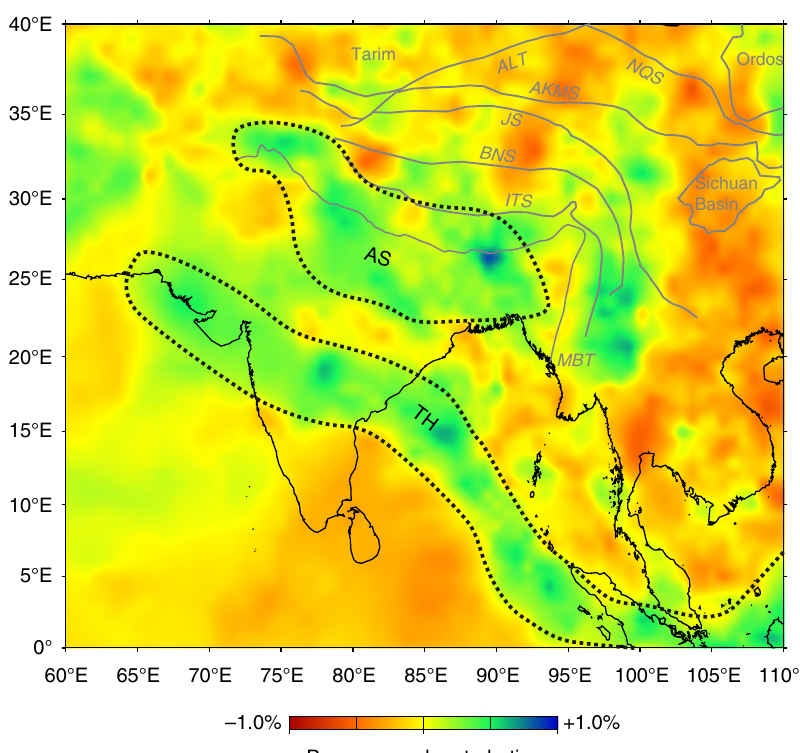
Fig. 7 Tomographic section at 1016 km depth suggesting two previous detachment events. Two high-speed anomalies, denoted as TH and AS, are observed. On the basis of their geometry and position, the TH anomaly is interpreted as the detached Neo-Tethyan oceanic slab 54,55 , whereas the AS anomaly might be the signature of the detached Tibetan lithospheric mantle during the India – Asia collision 55 . The Generic Mapping Tools 66 was used to create the map, with the open source dataset of P-wave speed variations from Li et al. 70